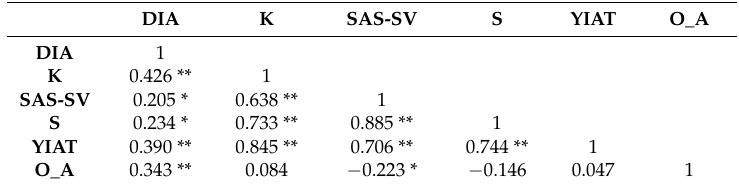
Table 2. Correlation analysis between Diagnostic Interview for Internet Addiction and Internet and Smartphone related scale.